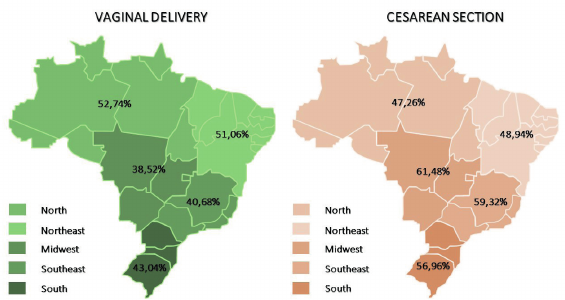
Figure 2 - Relative frequency according to the type of child- birth in the Brazilian regions (n = 16.175, Brazil, 2013). Source: PNS,